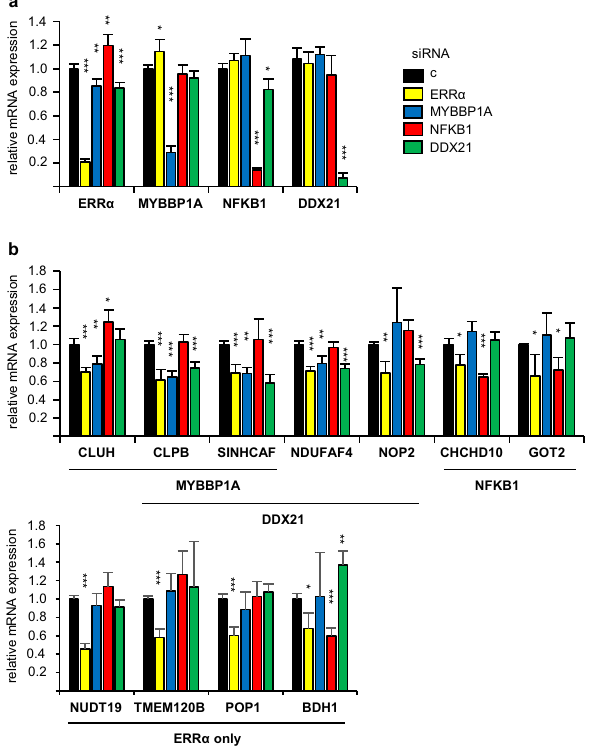
Figure 5. Regulation of gene expression by ERRα and suspected co-regulators. ( a, b) MDA-MB-231 cells transfected with siRNAs directed against the indicated transcription factors were analyzed for expression of the indicated genes by RT-qPCR. Results are presented relative to control conditions with bars representing mean + /- sem of three independent experiments performed in triplicate. ( a) Validation of siRNA effect on their corresponding direct targets. ( b) Analysis of ERRα target gene. As evaluated by t-test, variations are not significant unless indicated by *** p < 0.001, ** p < 0.01, * p <